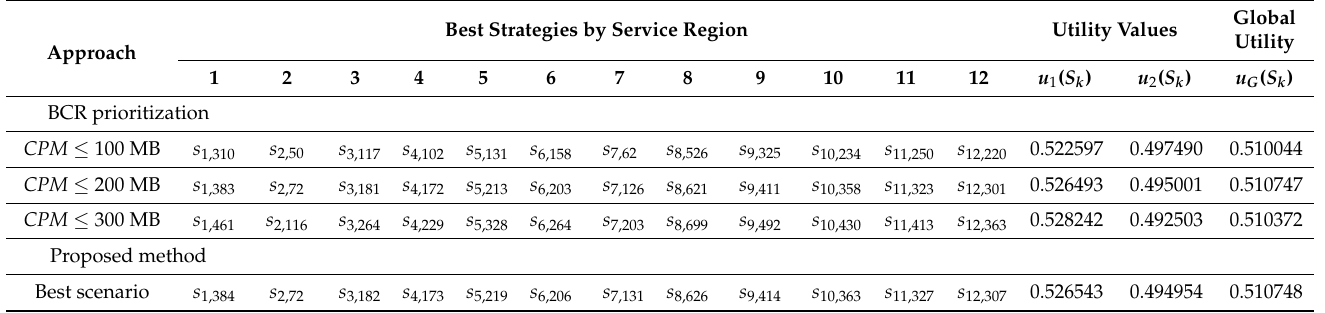
Table 8. Comparisons of results between BCR prioritization and the proposed